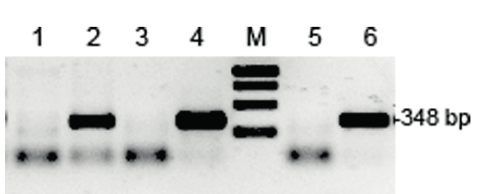
Fig. 3. PCR analysis of Rcc DNA in infected winter barley (cv. Fridericus –lanes 1─2 and cv. Cinderella, lanes 3─4) seeds and leaves Lanes: 1. seeds of cv. Fridericus, 2. leaves (GS 83, week 25) of cv. Fridericus, 3. seeds of cv. Cinderella, 4. leaves (GS 83, week 25) of cv. Cinderella, M. 1.0 kbp DNA ladder Plus (Thermo